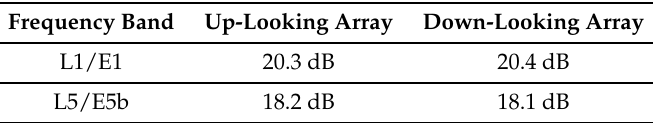
Figure 5. Top view of the up-looking array ( a ), and back view (uncovered) of the down-looking array ( b ). The up-looking array image includes the baseline used to define each antenna element by a { m } pair of values. The azimuthal pointing angle ϕ is defined anti-clockwise from vector (cid:126) m to (cid:126) n . i , n i The off-boresight pointing angle θ is defined from vector (cid:126) z to the antenna array ground plane. Table 2. Measured directivity of the